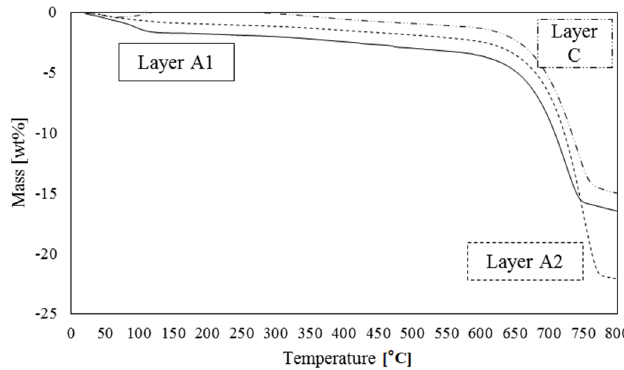
Figure 3. The characteristic thermogravimetric analysis (TGA) curves of the samples from layers A1, A2, and C from Sra Ouertane phosphate rock.